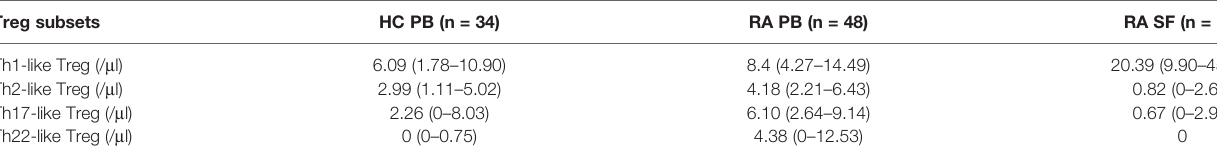
TABLE 3 | Absolute counts of different Th-like Treg cells in HC PB, RA PB, and RA SF. Treg subsets